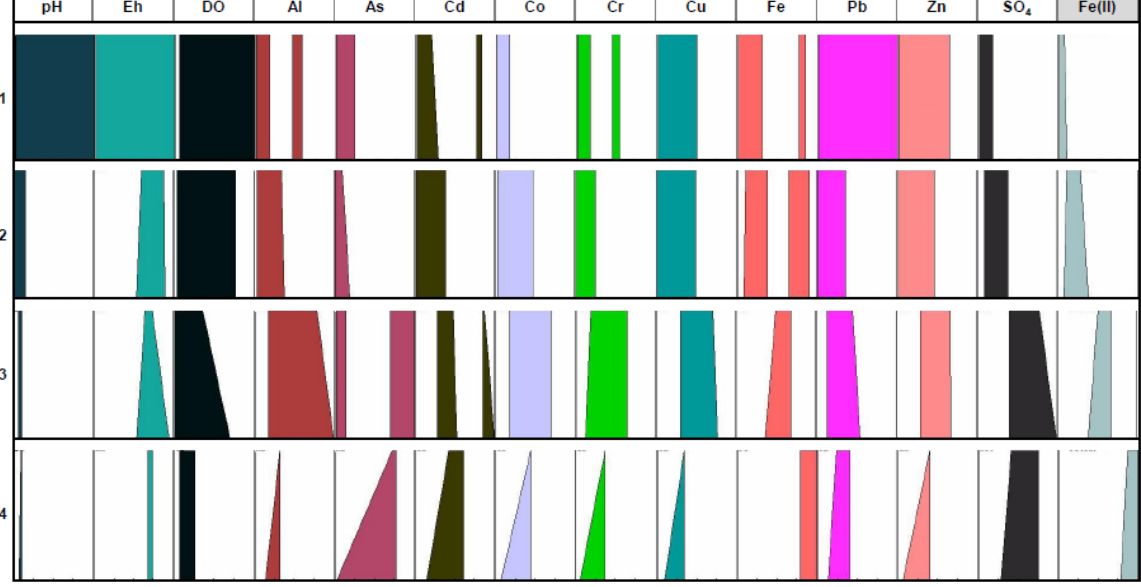
Figure 3. Fuzzy rules related to dry season taking Fe(II) as the consequent.